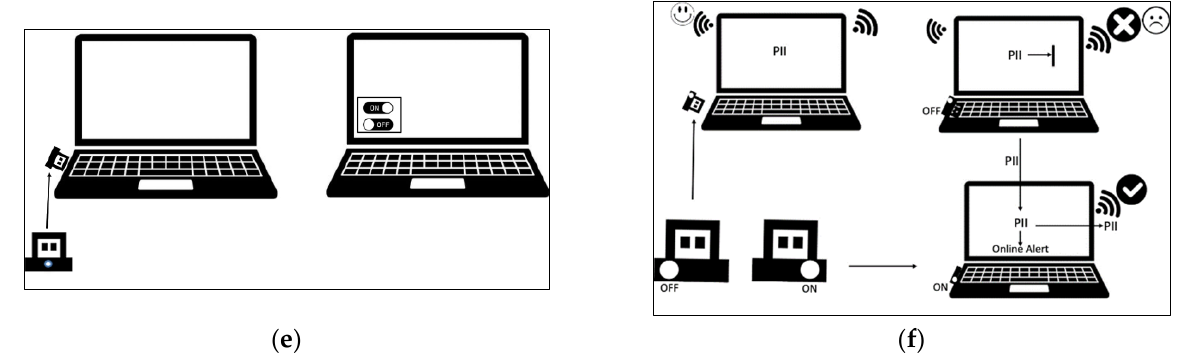
Figure 4. ( a ) In the traditional computing system, the third-party permissions create primary and secondary attack surfaces that bad actors exploit to breach the computer. ( b ) Zero vulnerability computing (ZVC) completely obliterates the attack surface to achieve a zero attack surface. ( c ) Conceptual diagrammatic representation of primary and secondary attack surfaces. ( d ) Diagram- matic representation of SOS obliterating the attack surface and providing a web interface. ( e ) ICOS with a soft switch and LED indicator. ( f ) ICOS operation with a hard toggle switch.